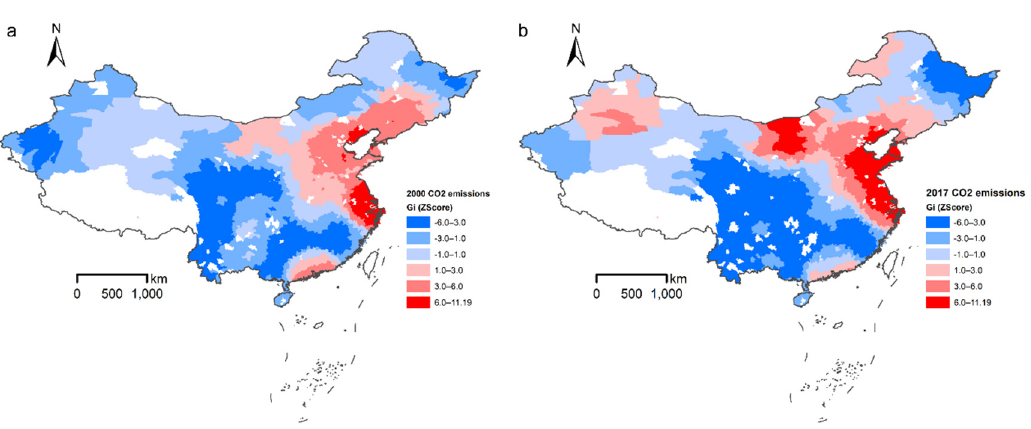
Figure 7. Spatial autocorrelation analysis (local Moran’s I clustering) of CO 2 emissions in China in ( a ) 2000 and ( b ) 2017. Red and blue areas indicate positive and negative spatial correlation, respectively.